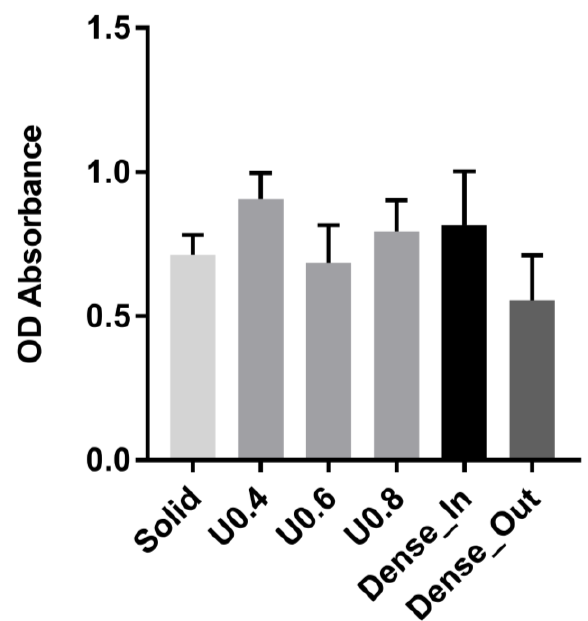
Figure 6. Adhesion of cells to uniform and gradient porous structures and to solid control sample as measured by MTS assay after 4 h. The optical absorbance (OD) was measured at 490 nm. Data are presented as mean ± SD ( n = 3). No statistically significant differences were observed between scaffolds.